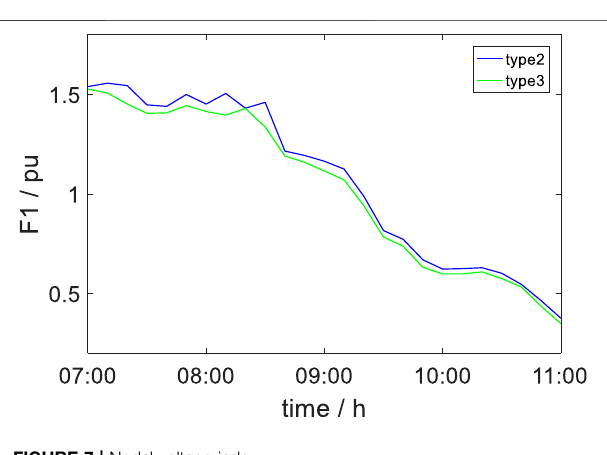
FIGURE 5 | Active power output.